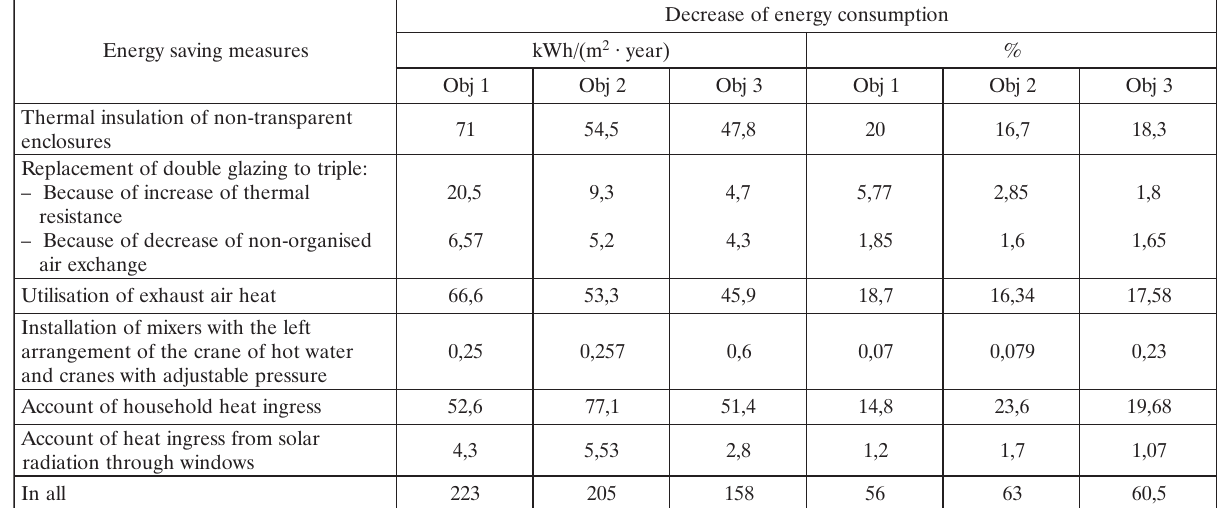
noitpmusnocygrenefoesaerceD